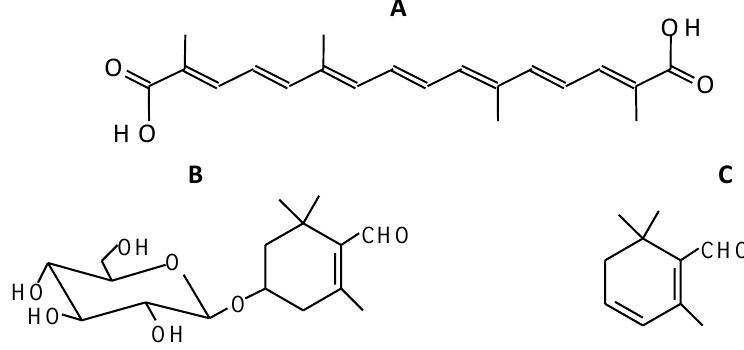
Figure 1. Chemical structures of crocetin ( A ), picrocrocin ( B ) and safranal ( C ).